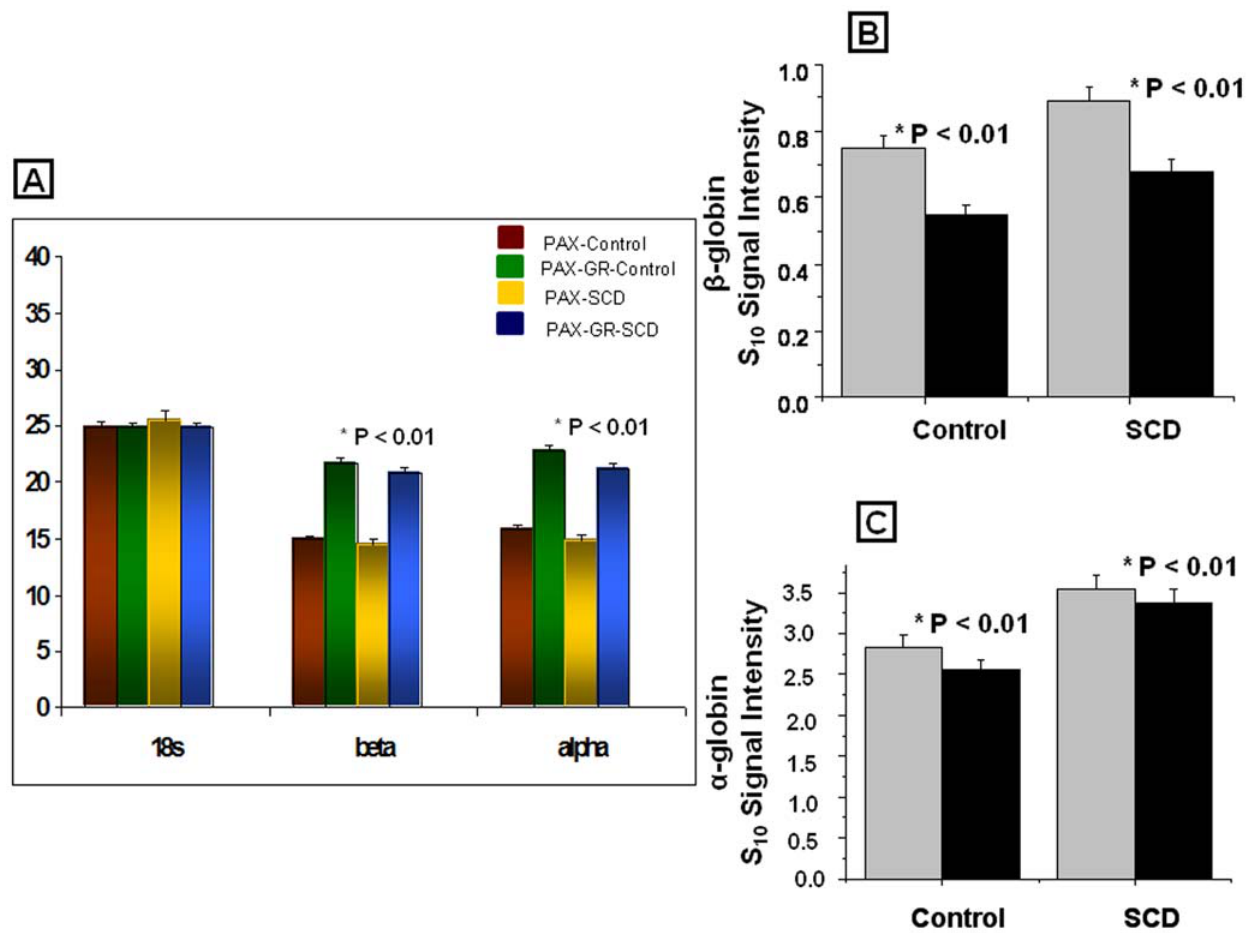
Figure 2. A . Expression of 18s, globin transcripts a , b by RT-PCR in PAX and PAX-GR from control and SCD samples. Ct values in the expression of globins are given as mean 6 SD for each group. Red bar - PAX-Control; Green bar - PAX-GR Control; Yellow bar - PAX-SCD; Blue bar - PAX-GR-SCD. B . Normalized signal intensities for b globin probe sets from microarrays for control and SCD samples. Values are given as mean 6 SD. Grey bar - PAX; Black bar - PAX-GR. C . Normalized signal intensities for a globin probesets from microarrays for control and SCD samples. Values are given as mean 6 SD. Grey bar - PAX; Black bar - PAX-GR.